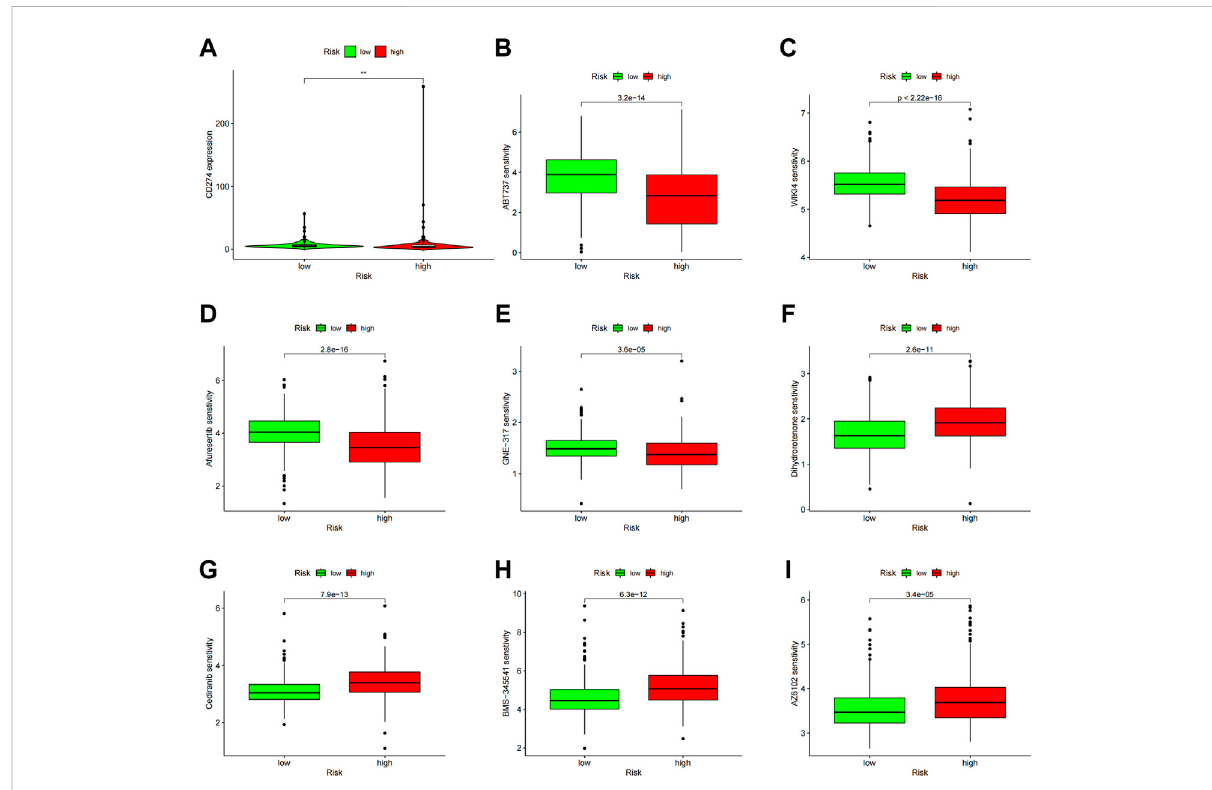
FIGURE 11 Comparisonoftreatmentdrugsensitivitybetweenhigh-andlow-riskgroups. (A) PD-L1expressioninhighandlow-riskgroups. (B – E) Predicted sensitivity of ABT737, WIKI4, Afuresertib, and GNE-317, which were candidate chemotherapeutic agents for high-risk patients. (F – I) Predicted sensitivity of Dihydrorotenone, Cediranib, BMS-345541 and AZ6102, which were candidate potent drug options for low-risk patients. PD-L1, programmed cell death ligand